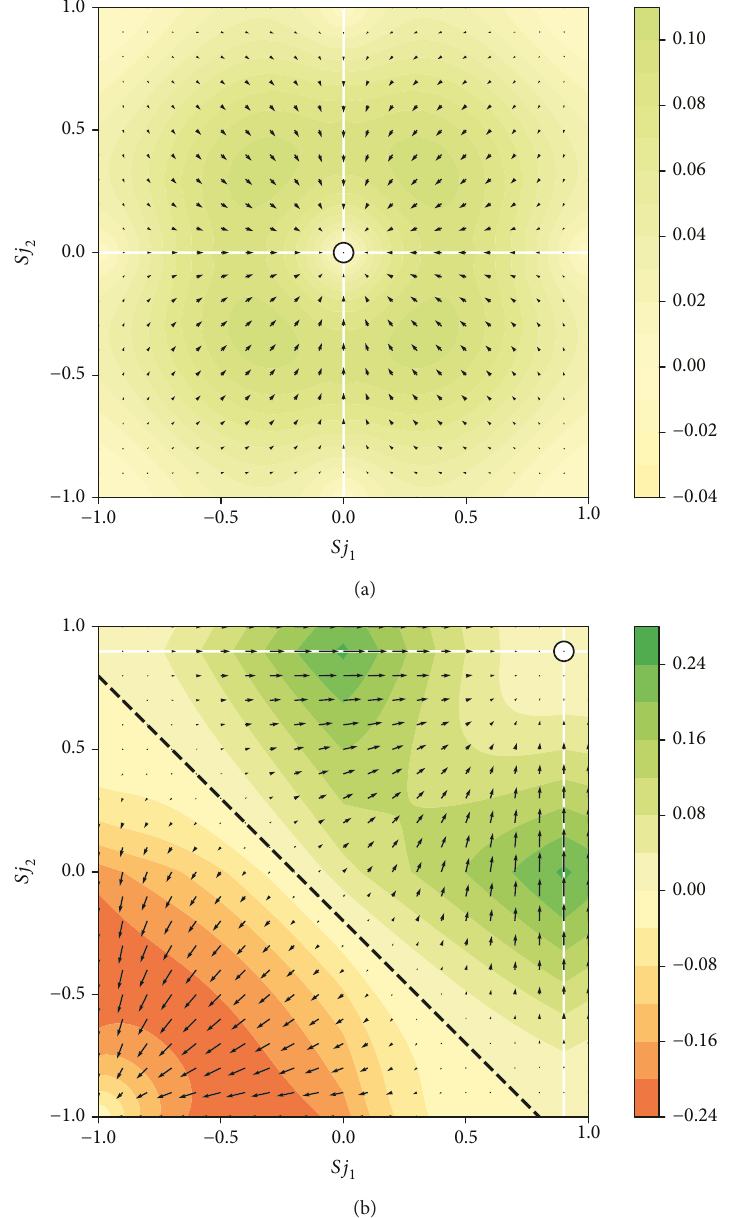
Figure 1: In fl uence by one agent on another changes depending on the location of each agent. This illustrates the in fl uence exerted by a central agent (white circle) on another agent at di ff erent locations in opinion